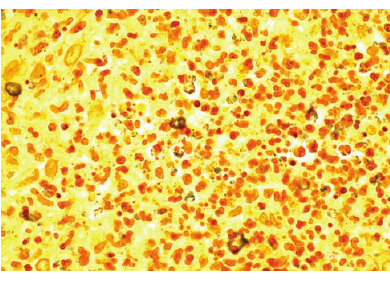
Figure 3. Short curved microorganisms seen singly and in clusters on the lymph node specimen (Warthin-Starry